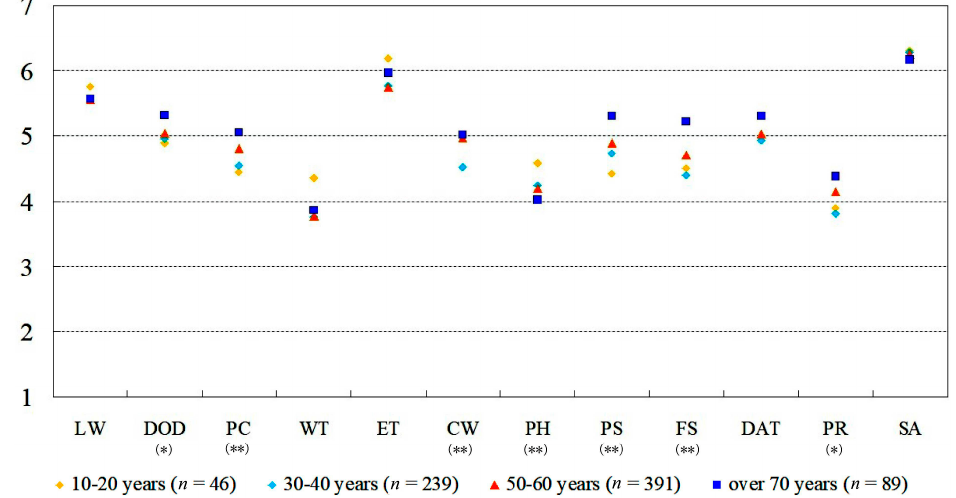
Figure 4. Choice preferences based on age. LW: Landscape the visitor wants to see; DOD: Degree of difficulty; PC: Pavement condition; WT: Watch the forest train; ET: Experience the forest bath; CW: Contact with landscape elements; PH: Photography; PS: Physical strength; FS: Facility status; DAT: Distance and time; PR: Privacy; SA: Satisfaction. ** Significant at the 0.01 level. * Significant at the 0.05 level.